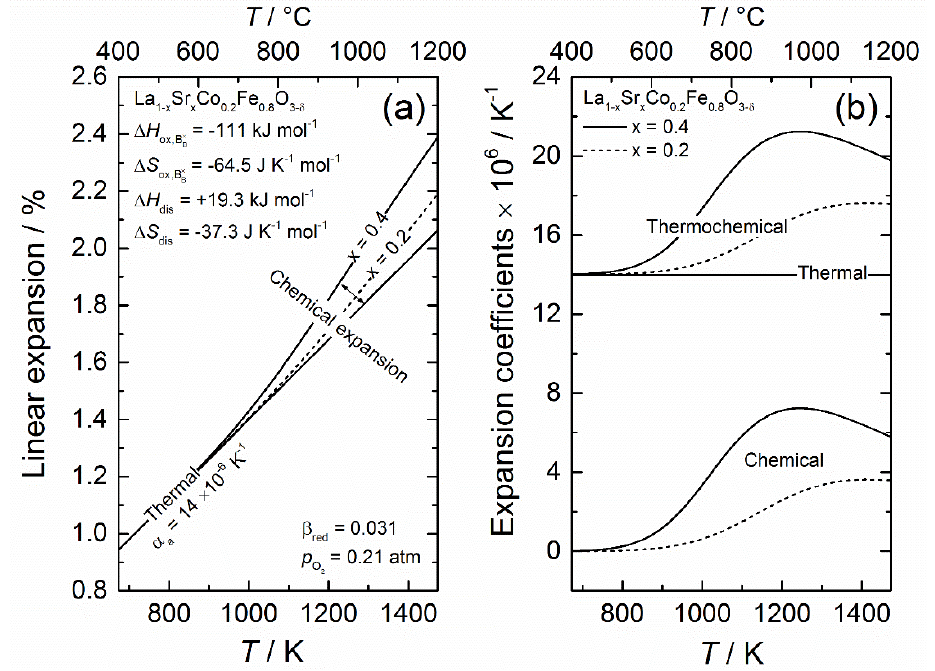
Figure 2. Linear expansion of La 1 − x Sr x Co 0.2 Fe 0.8 O 3 − δ (LSCF) as a function of temperature in air ( 𝑝 O 0.21 atm) for 20 mol% and 40 mol% strontium and 𝛽 red = 0.031 in ( a ) and the corresponding thermal,